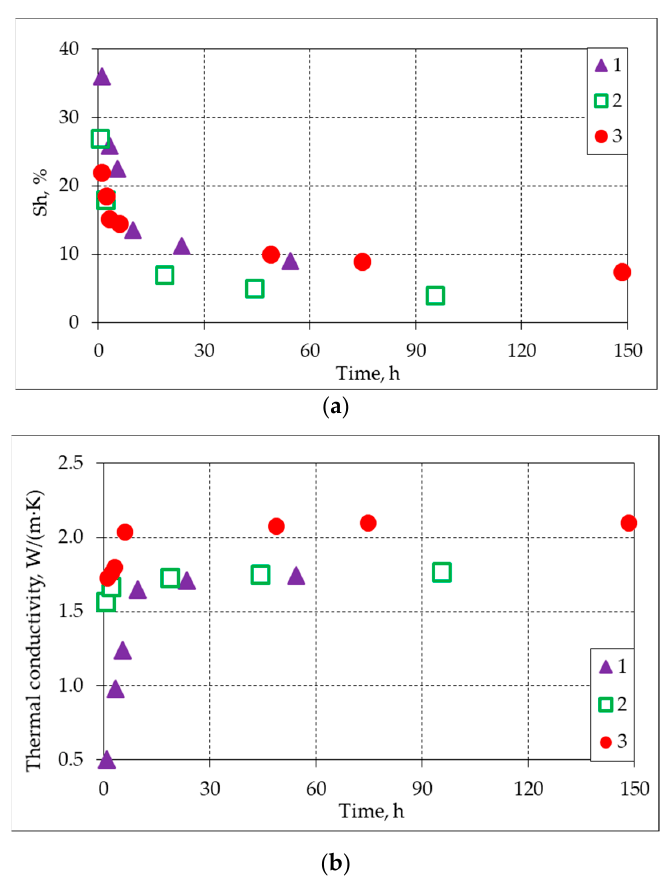
Figure 5. Time-dependent hydrate saturation ( a ); and thermal conductivity ( b ) in frozen samples with pore hydrate subject to self-preservation at t = − 5 − 6 ◦ C and P = 0.1 MPa. 1-fine sand-2 ( W = 17%); 2-silty sand ( W = 17%); 3-sandy clay ( W = 22%).